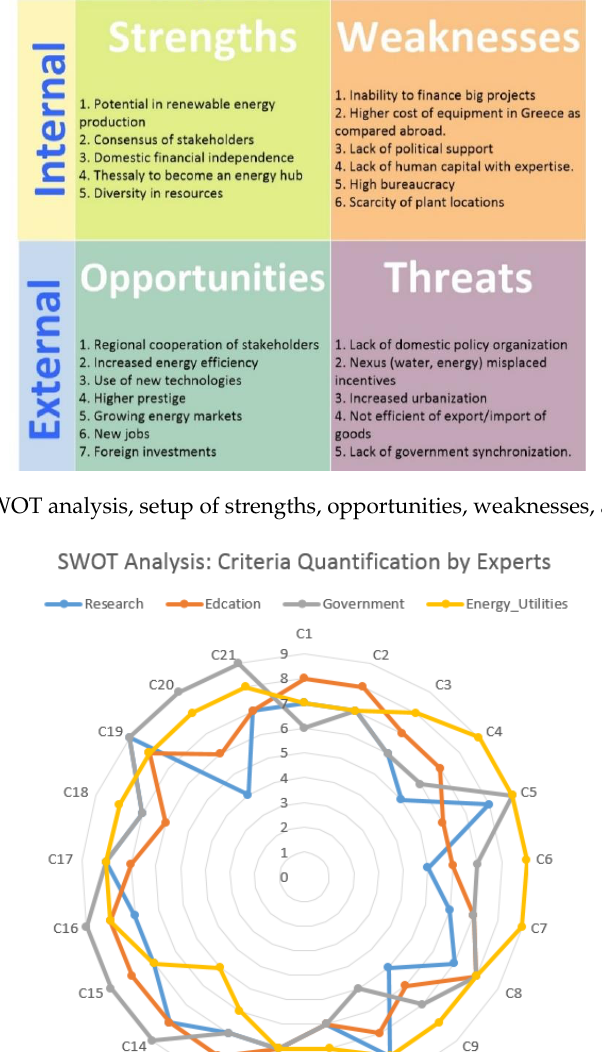
Figure 6. SWOT analysis, criteria quantification by experts before fuzzification. Table 4. Expert stakeholder criteria setup for the energy type selection.